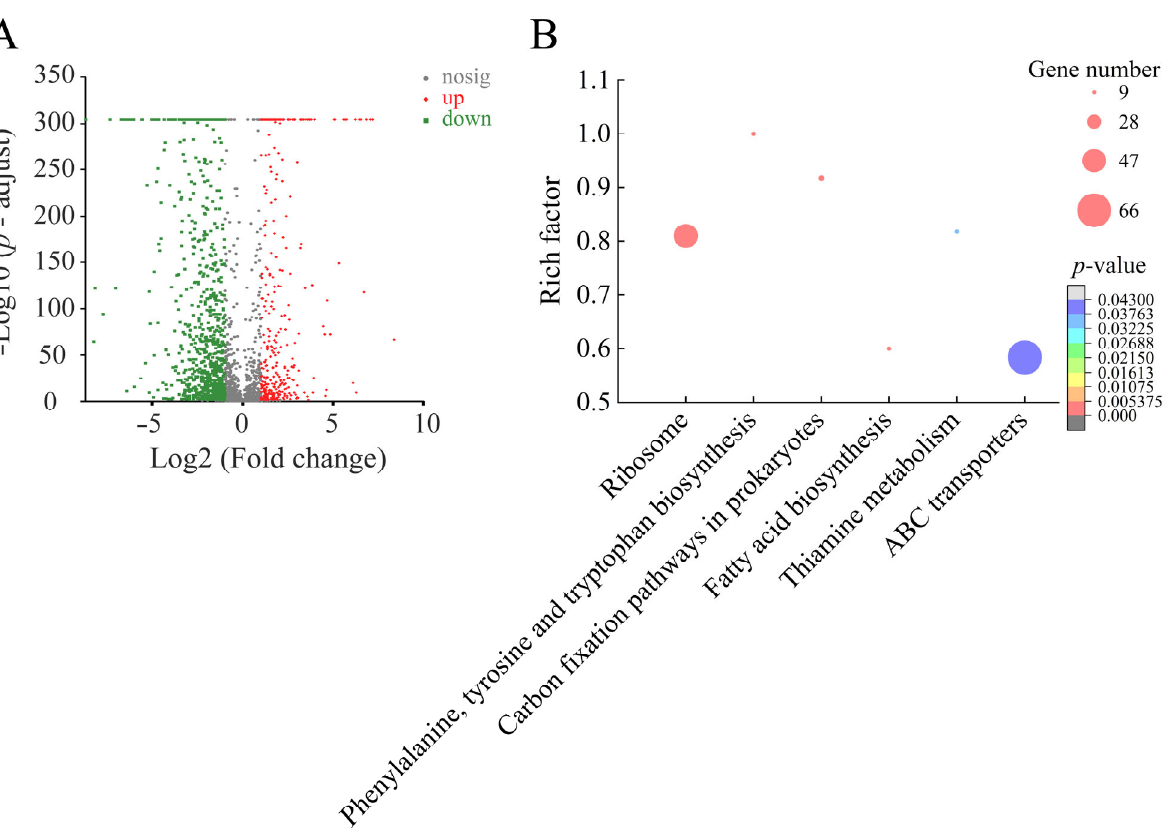
Figure 9. The six significantly altered metabolic pathways in E. faecalis C1 ‐ 1 mediated by Fragment 1 from C. communis Linn. ( A , B ) Volcano plot of differential gene expression and significantly changed metabolic pathways in E. faecalis C1 ‐ 1.